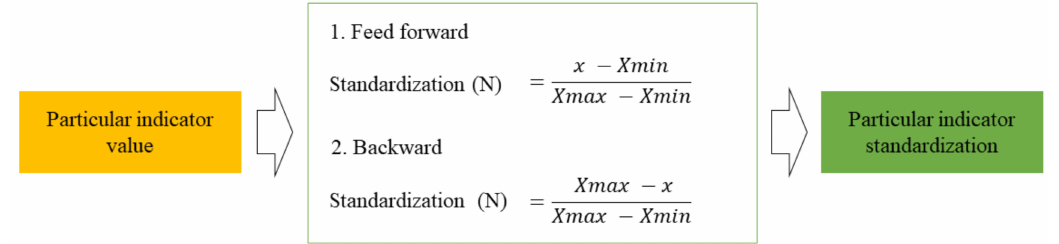
Figure 4. Minimum-to-maximum standardization